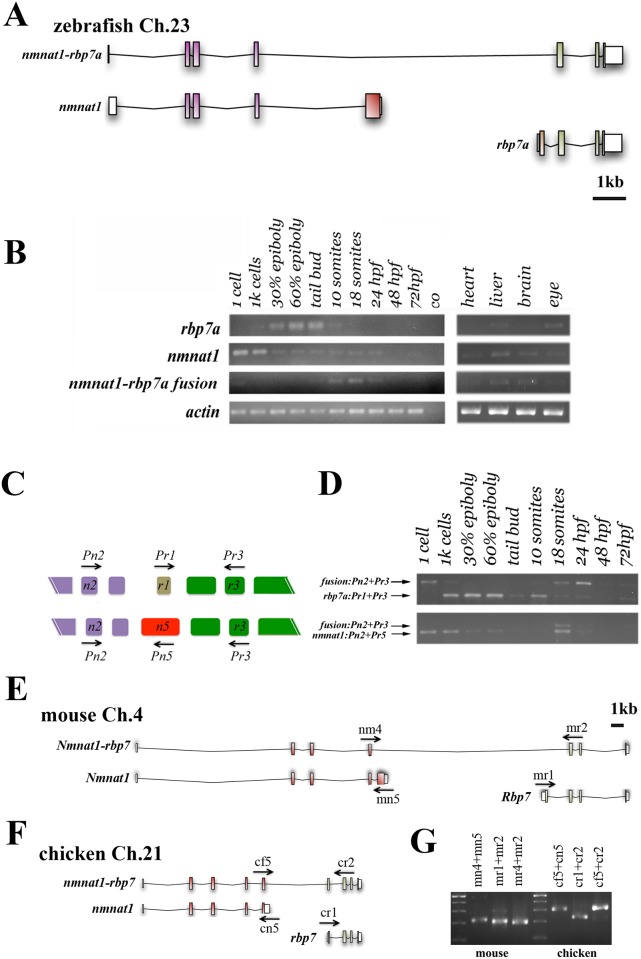

rbp7a forms a conserved fusion gene with nmnat1.[A] Schematic representation of the exon usage in nmnat1, rbp7a and nmnat1-rbp7a transcripts. Size of exons (boxes) and distances corresponds to the position in the genome. [B] Semi-quantitative RT-PCR analyses of rbp7a, nmnat1, and fusion isoform; mRNA generated from indicated embryonic stages and adult tissues. β-actin was used as a control for cDNA input levels. [C-D] Competitive PCRs reveal the ratios of different isoforms expression level during developmental stages. [C] Schematic indicating primers used for competitive amplification of rbp7a (Pr1+Pr3) versus nmnat1-rbp7a (Pn2+Pr3) in the upper panel and nmnat1 (Pn2+Pn5) versus nmnat1-rbp7a in the lower panel. The different isoform exons are colored respectively; purple: nmnat1, green: rbp7a; the unique exon which belongs to nmnat1 or rbp7a is shown in red and brown. [D] Competition RT-PCR in different embryonic stages, note the temporal changes in ratios of long (nmnat1-rbp7a) versus short (rbp7a and nmnat1) PCR products, which were indicated the different dominated expression time windows for isoforms. [E, F] Schematic representation of exon usage of Rbp7, Nmnat1, and the Nmnat1-rbp7 transcriptions in mouse [E] and chicken [F]. [G] RT-PCR analyses of embryonic mRNA form mouse (E14) and chicken (d9) confirming expression of Nmnat1, Rbp7 and Nmnat1-rbp7 transcripts.